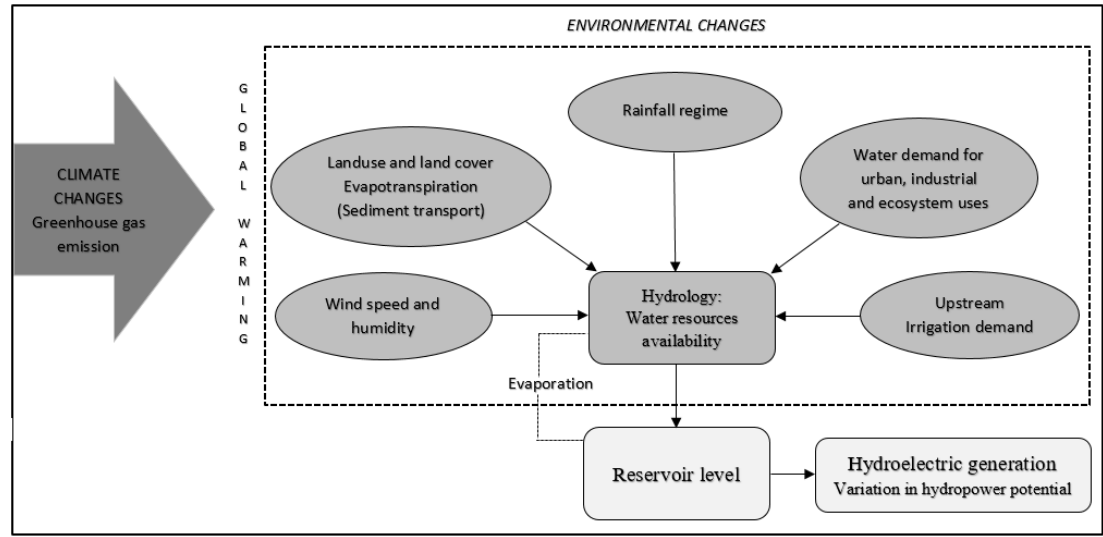
Figure 3. Framework—Climate change and reservoir management.